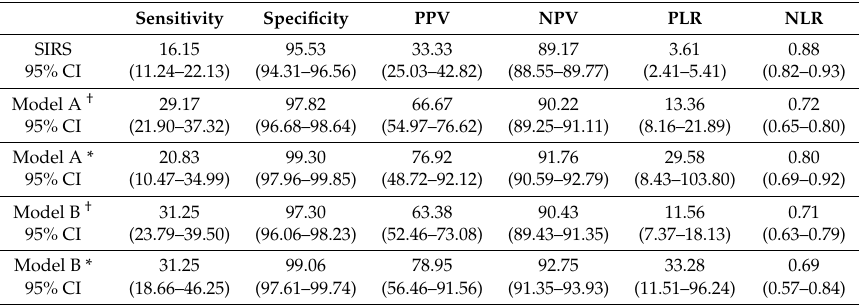
Table 5. Performance parameters of SIRS, Model A and Model B.